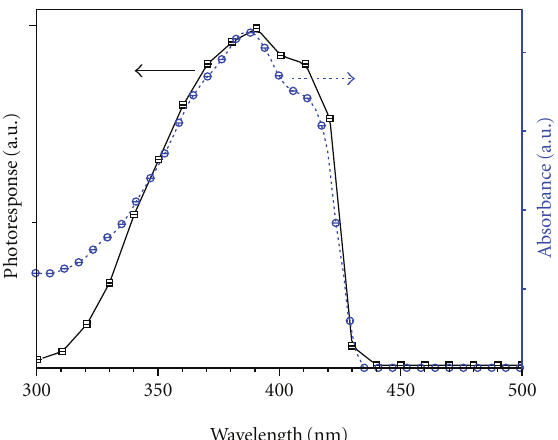
Figure 5: Photoresponse spectra of the device ITO/PEDOT:PSS/PFE:BNDI (3:1)/Al illuminated from ITO electrode and absorbance spectra of Lam/PFE:BNDI (3:1) sample.